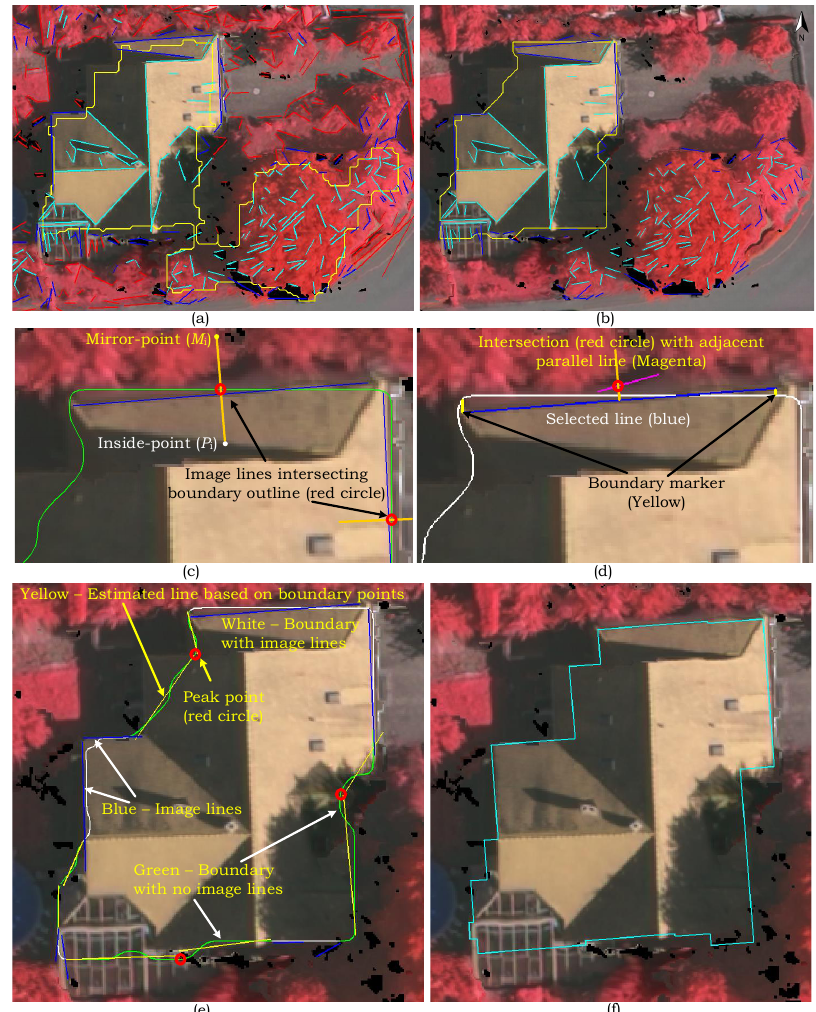
Figure 11. Building regularisation process: ( a ) Candidate boundary region (yellow) from building mask and image extracted lines; ( b ) Clustered lines to candidate region and final detected building; ( c ) Boundary lines selection; ( d ) Edge selection and boundary marking; ( e ) Edge line estimation for unmarked boundary outline; and ( f ) 2D building footprint/regularised